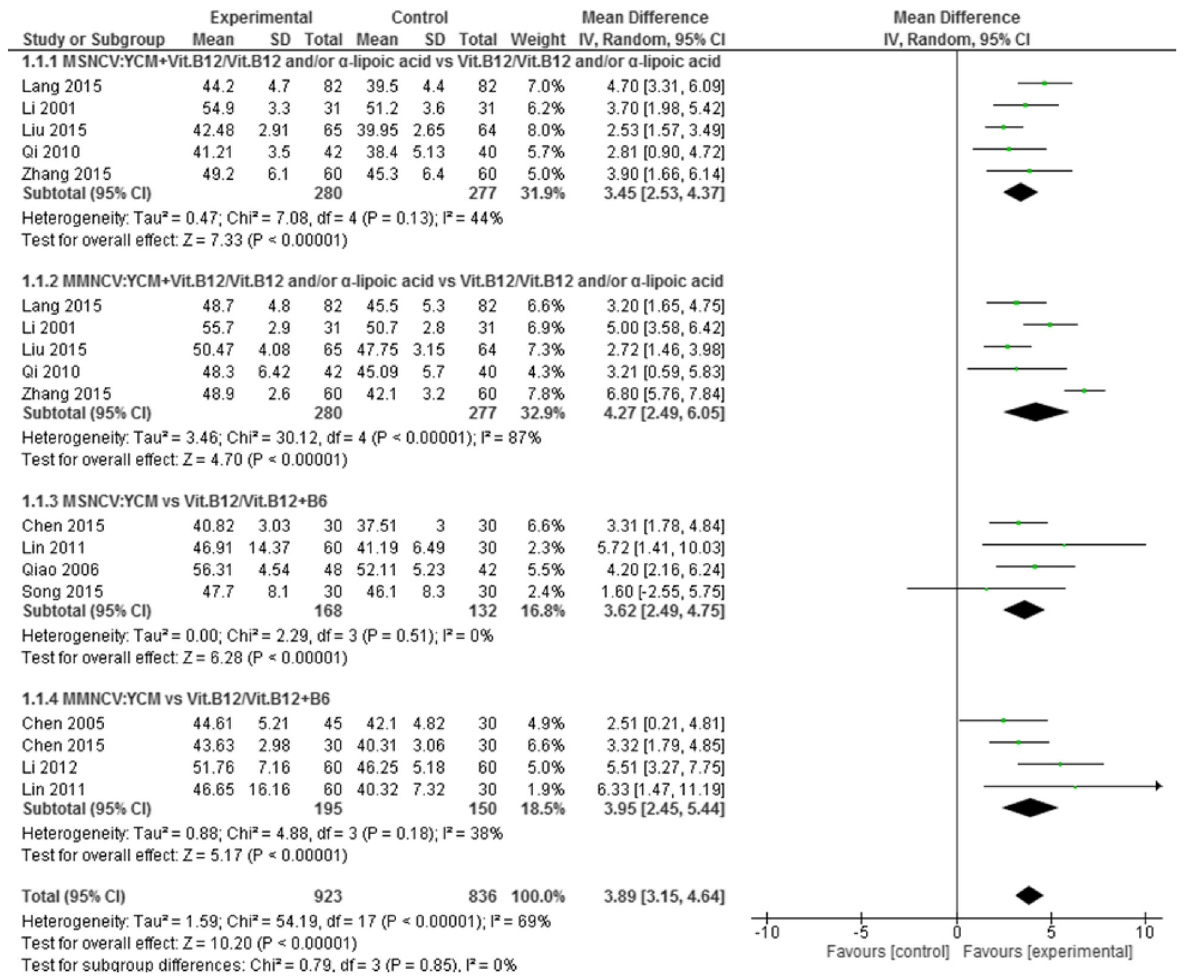
Fig. 4 Forest plot of median nerve conduction velocity of YCM on diabetic peripheral neuropathy. Note: MSNCV: median sensory nerve conduction velocity; MMNCV: median motor nerve conduction